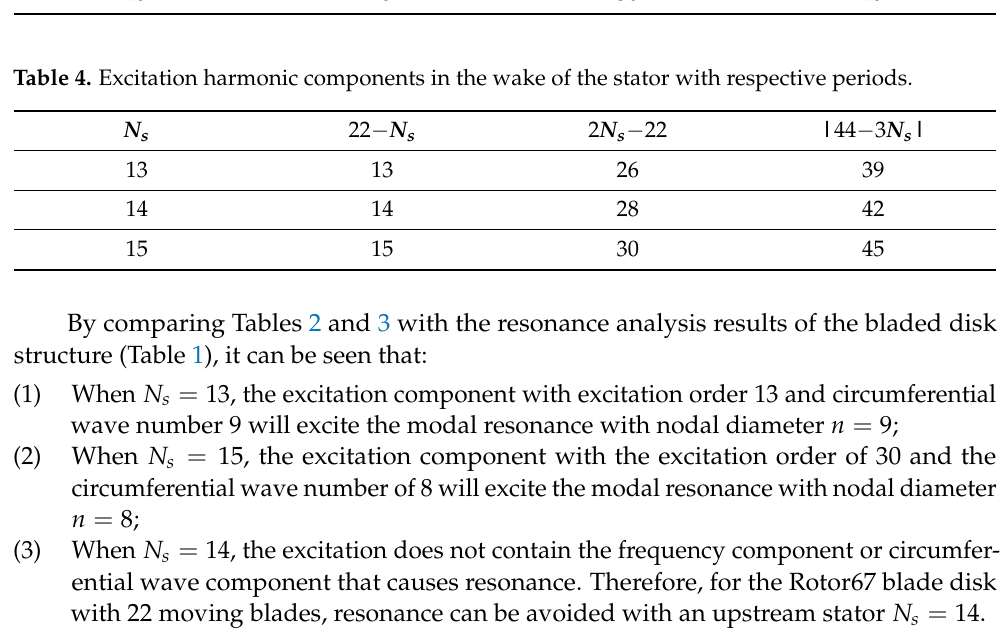
Table 3. Stator wake excitation frequency components with respective periods. Table 4. Excitation harmonic components in the wake of the stator with respective periods.